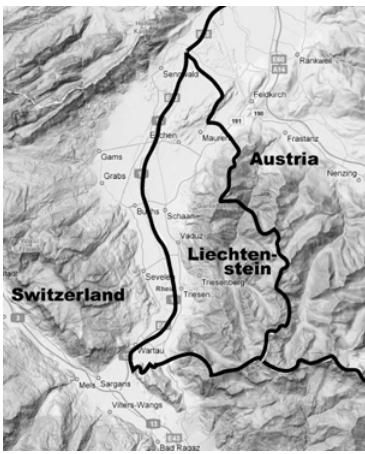
Fig. 1. Overview of Liechtenstein and its surroundings